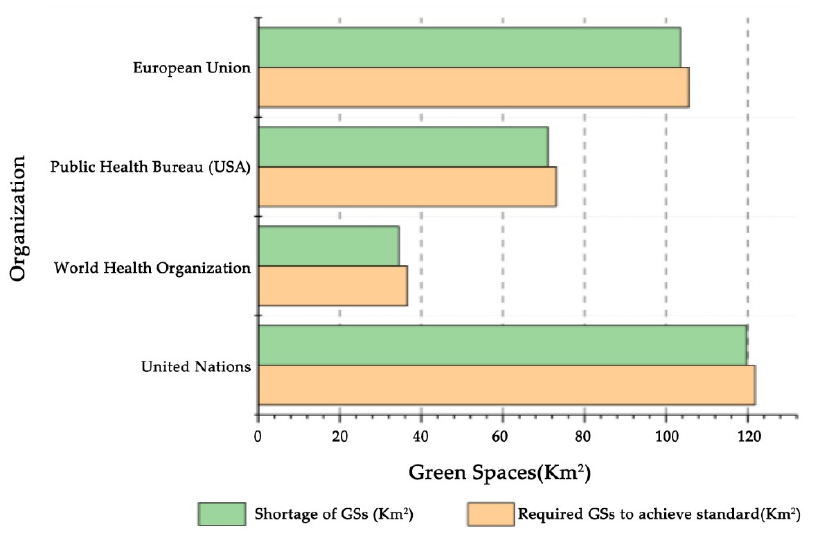
Figure 4. Shortage and required GSs (km 2 ) in Jeddah City.